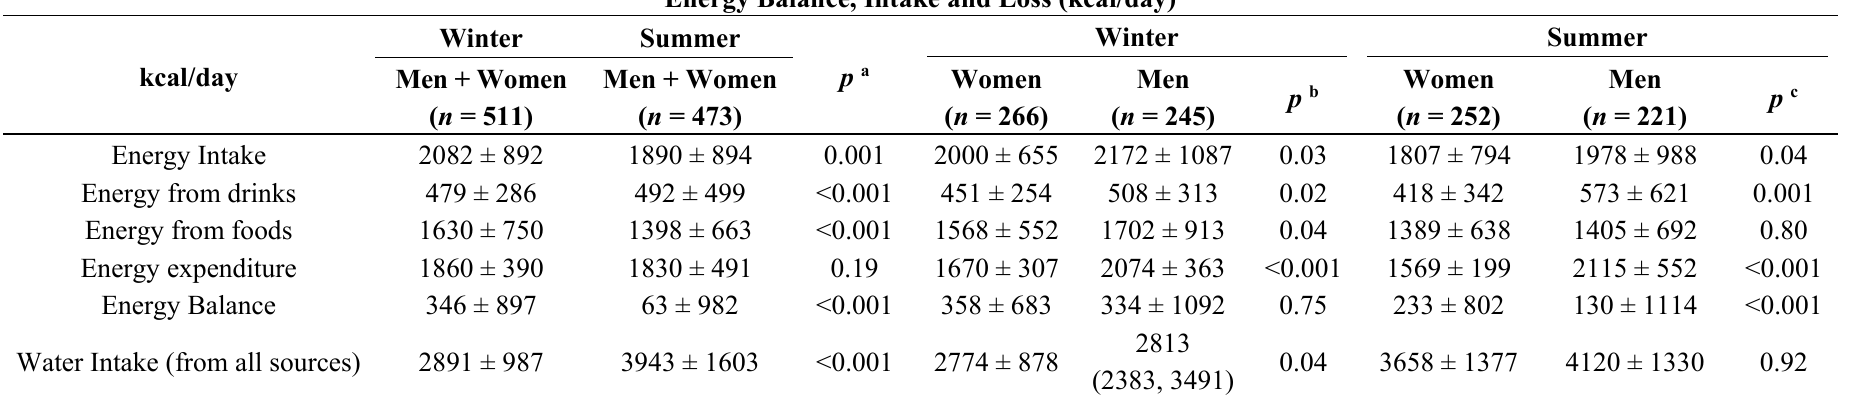
Table 2. Comparison of energy intake from all sources, also itemized as energy from drinks and from foods, energy expenditure estimated from physical activity and energy balance for the total sample (men and women) during winter and summer and energy balance between men and